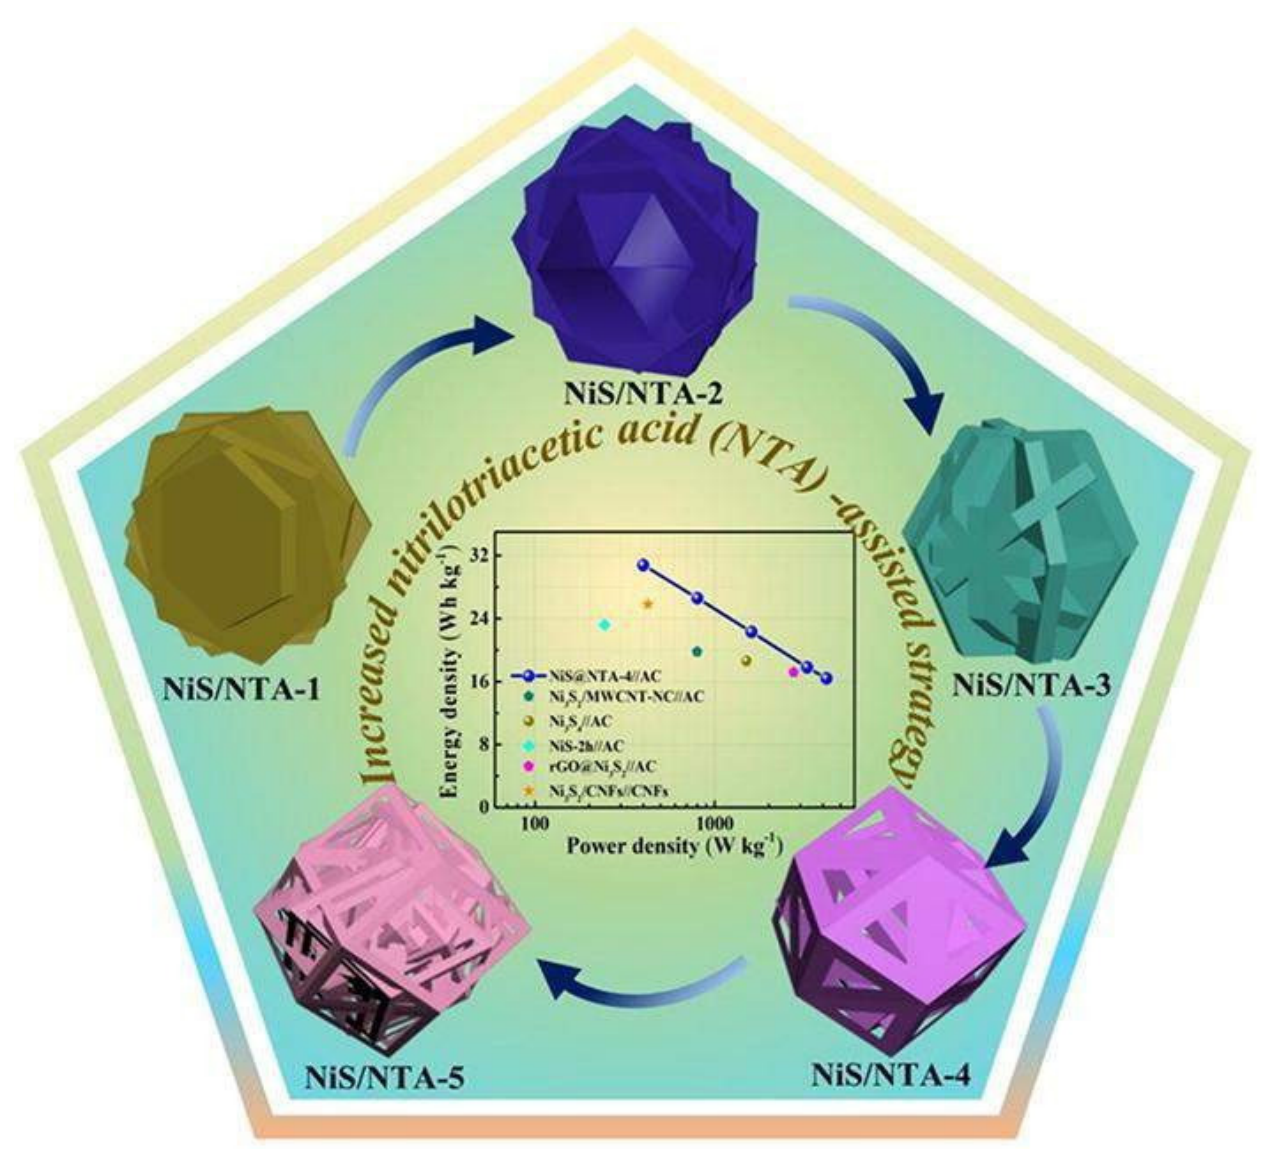
Figure 31. NiS/carbon hexahedrons produced from a nitrilotriacetic acid assembly for supercapaci- tors. Reproduced with permission from [117].